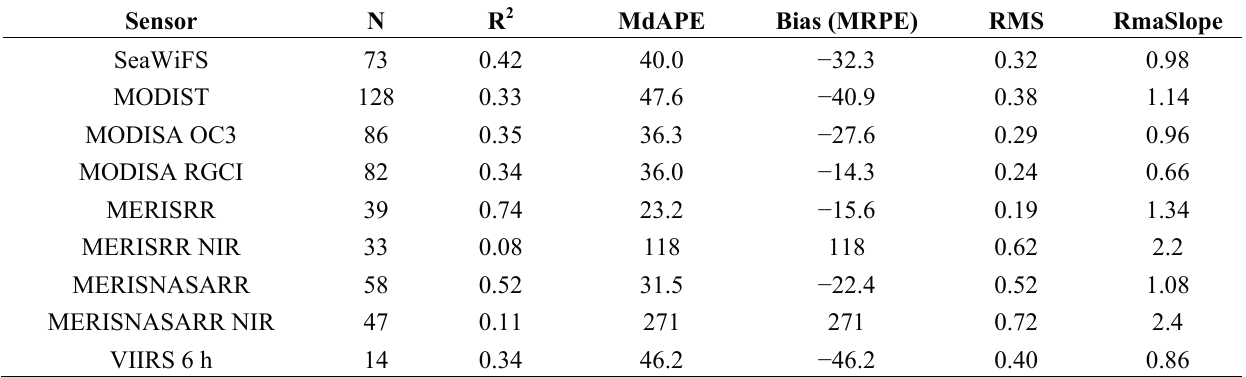
Table 3. Statistics for match-ups with in situ Chla ≥ 1 mg m − 3 with up to a 3-h time difference (6 h for VIIRS) and at least five valid pixels. Column names are as in Table 2. The shaded rows are for nonstandard algorithms: RGCI, red-green chlorophyll index; NIR, using near-infrared bands. OC, ocean